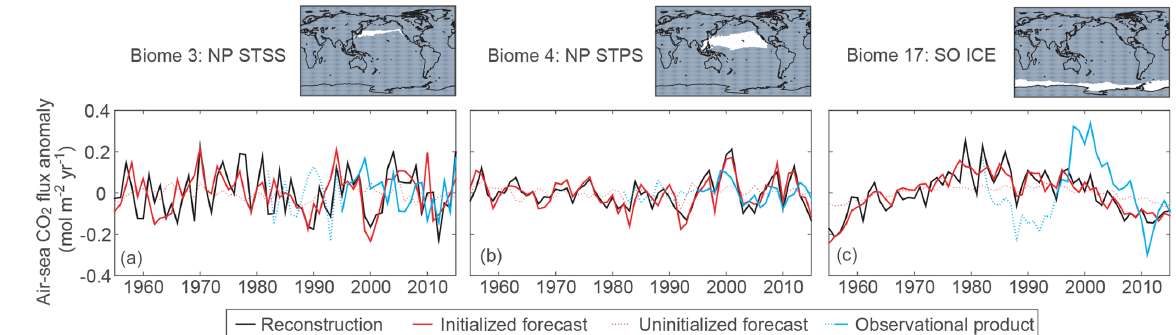
Figure 8. Temporal evolution of the biome-averaged air–sea CO 2 flux anomalies in the (a) NP STSS, (b) NP STPS, and (c) SO ICE biomes (molm − 2 yr − 1 ). The following time series are plotted: (black) reconstruction, (red) CESM-DPLE initialized forecast, (red dotted) CESM- LE uninitialized forecast, and (blue) Landschützer et al. (2016) observationally based product. The CESM-DPLE time series is the linearly detrended, drift-corrected, ensemble mean forecast anomalies in year 1; the reconstruction, CESM-LE ensemble mean, and observed time series have been transformed to anomalies by removing the linear trend. Observations prior to 1995 are dotted due to lower observation density. Positive anomalies indicate anomalous ocean outgassing.